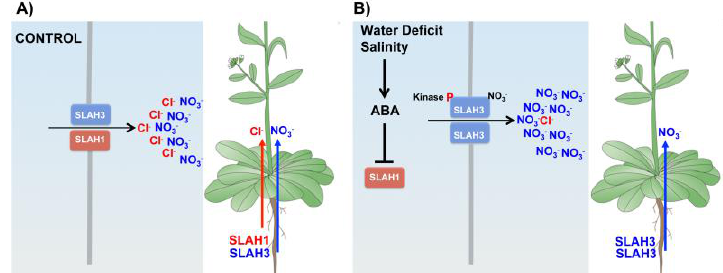
Figure 4. Regulation of root xylem chloride (Cl − ) translocation by the anion channels SLAH1 and SLAH3 according to environmental cues. Under favorable growing conditions ( A ), high transcriptional activity of both SLAH1 and SLAH3 genes determines the formation of heteromeric SLAH1/SLAH3 complexes in the xylem-pole pericycle. The SLAH1 channel does not transport anions itself, but modifies the kinetic properties of SLAH3, which increases its Cl − conductance by 7 times and mediates xylem translocation of both Cl − and nitrate (NO 3 − ) anions. However, under abiotic stress conditions like water deficit or salinity ( B ), gene expression of AtSLAH1 is strongly inhibited by an abscisic acid (ABA)-dependent regulatory pathway. This favors the formation of SLAH3/SLAH3 homomers, which significantly reduces the Cl − conductance of SLAH3, decreasing xylem Cl − translocation but maintaining xylem NO 3 − translocation. The schematic representation describes the regulatory mechanism described by Cubero-Font et al. [176].